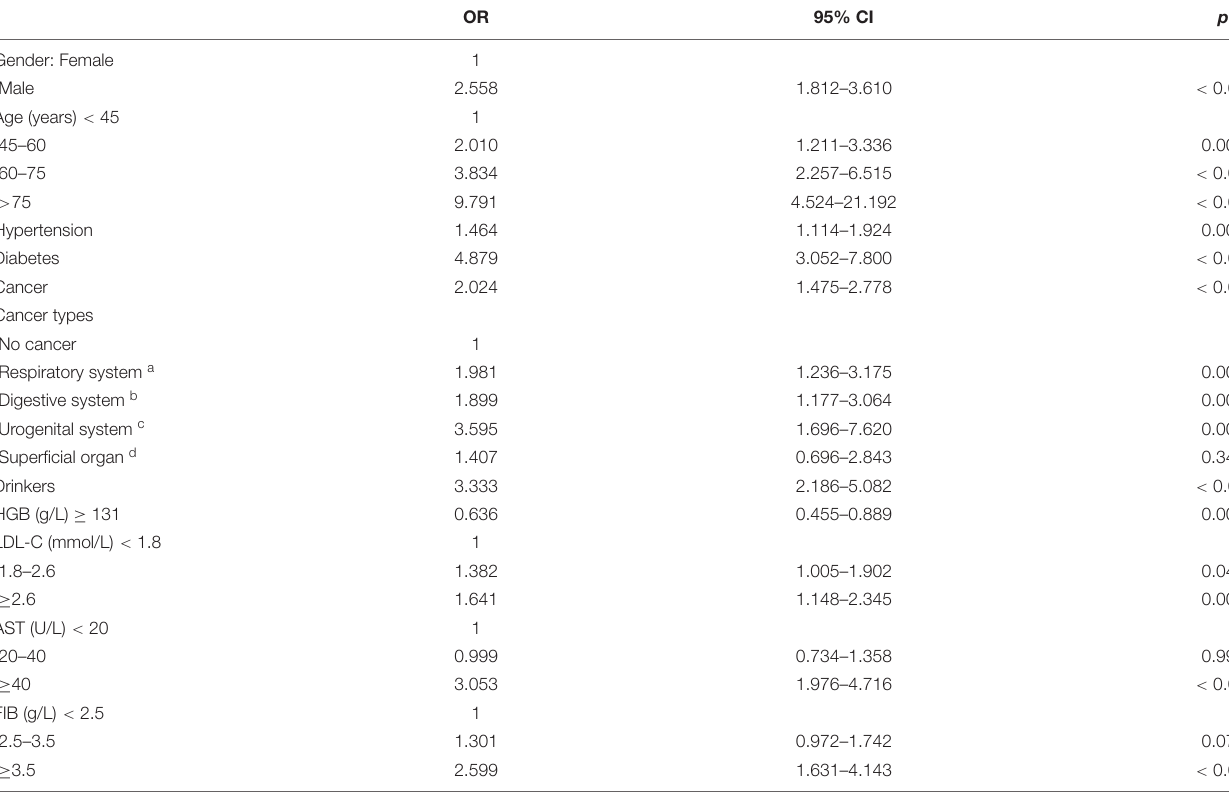
TABLE 3 | Logistic regression analysis for influencing factors for CAD.